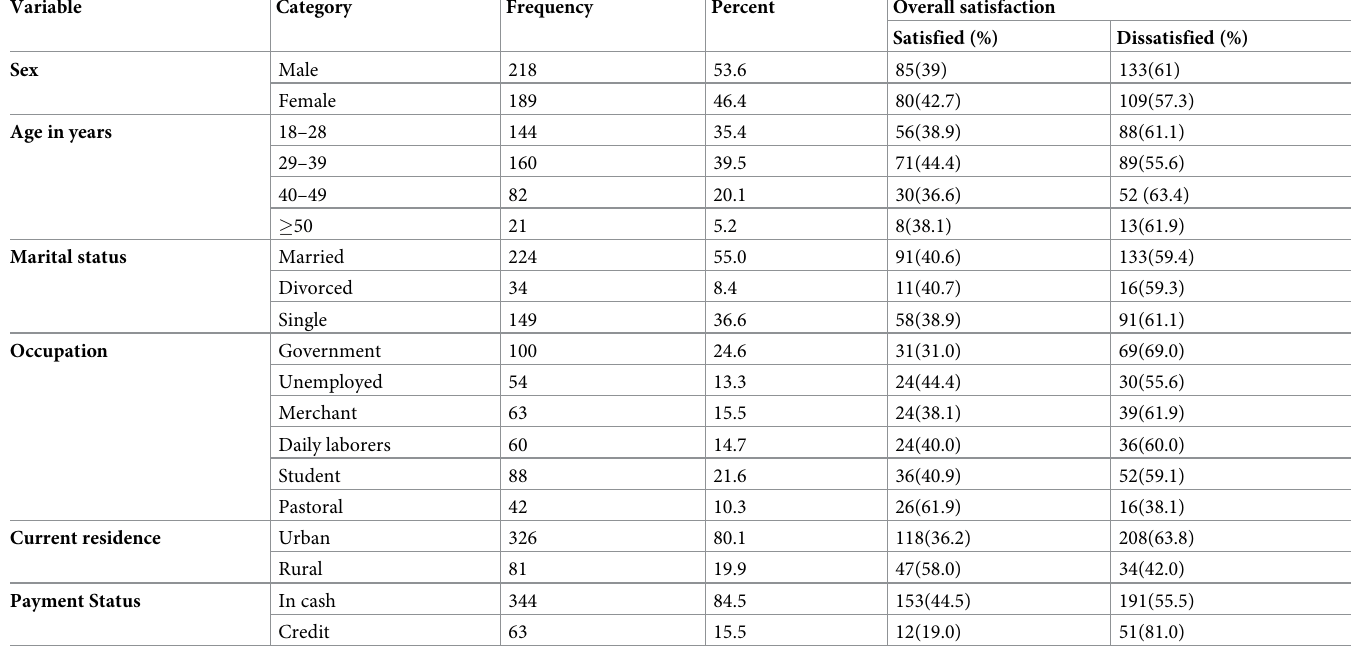
Table 1. Socio-demographic characteristics of the study participants (N =